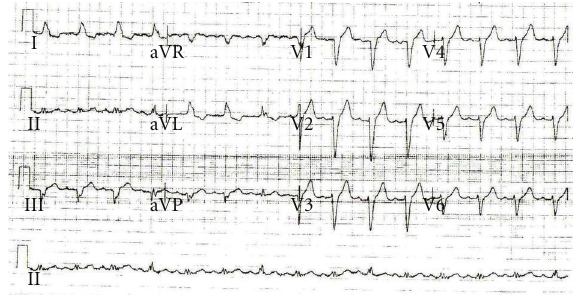
Figure 1: ECG immediately after the patient attended to A&E.